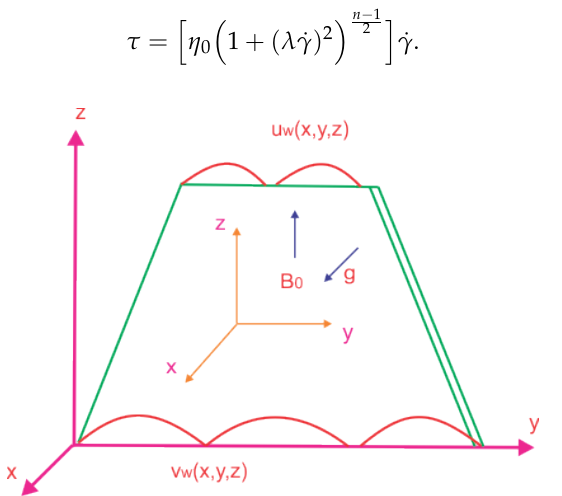
Figure 1. Geoemtrical demonstrarion of the physical